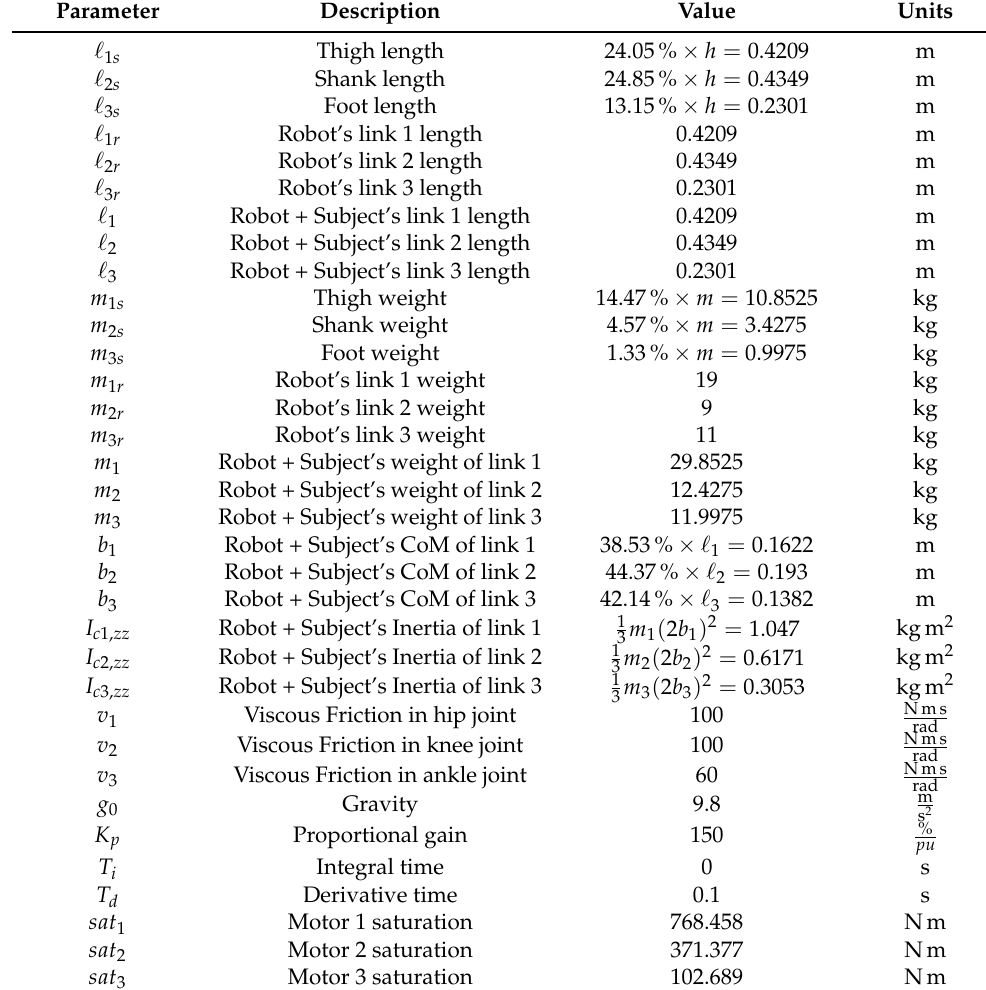
Table 2. LLRR parameters for simulation including a subject of h = 1.75m height and m = 75kg